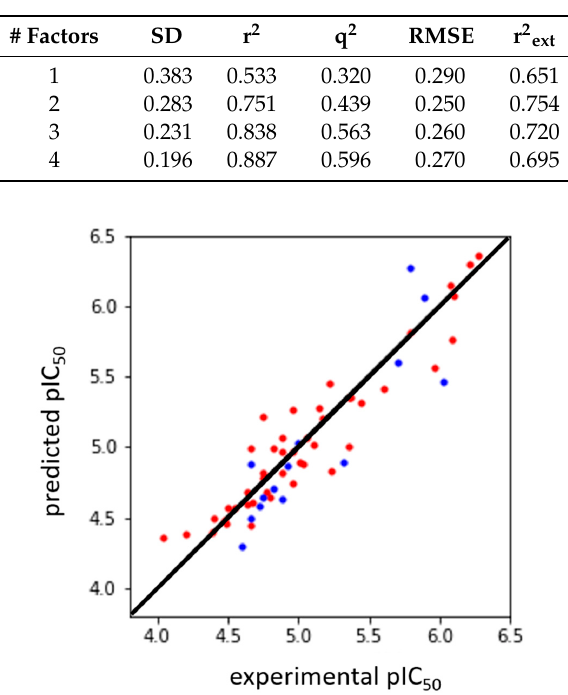
Figure 5. Scatter plot showing experimental vs. predicted pIC 50 values for training ( n = 45, red solid circles) and external ( n = 14, blue solid circles) sets, respectively. Bisector line is depicted in black. The r 2 and r 2ext coefficient values were equal to 0.887 and 0.695, respectively. Contour maps of grid-based descriptors are reported in Figure 6 to spot positive or negative molecular regions for the activity of the compounds. Hydrophobic substituents at position 5 and 6 of isatin or indoline cores are detrimental for activity, much more than those at the ortho position of the